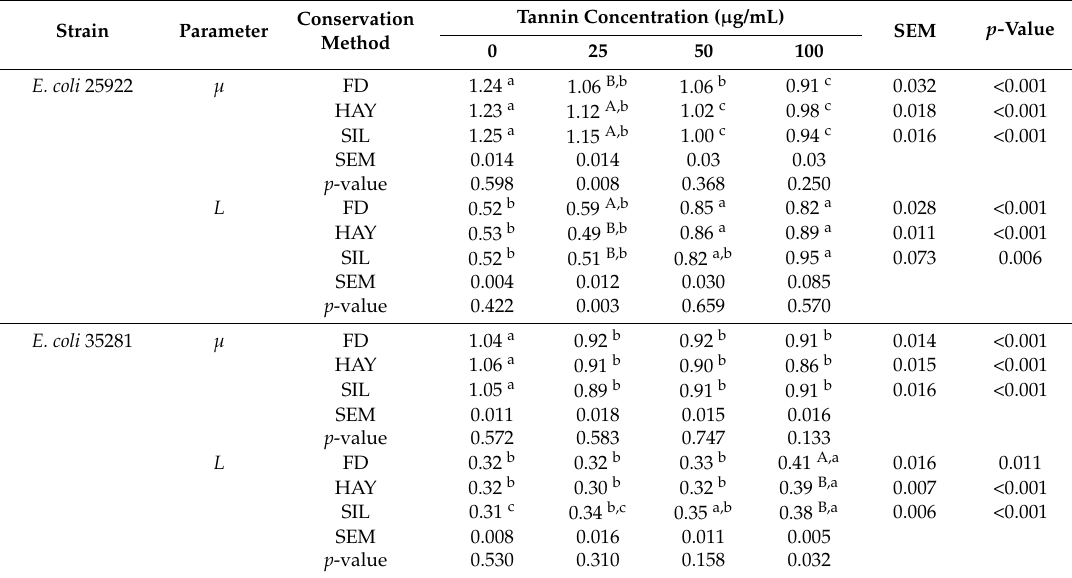
Table 5. Effects of condensed tannins in purple prairie clover conserved as freeze-dried forage (FD), hay (HAY) or silage (SIL) on the growth of the Escherichia coli 25922 and 35218. Tannin Concentration ( µ g/mL) Conservation Strain Parameter Method